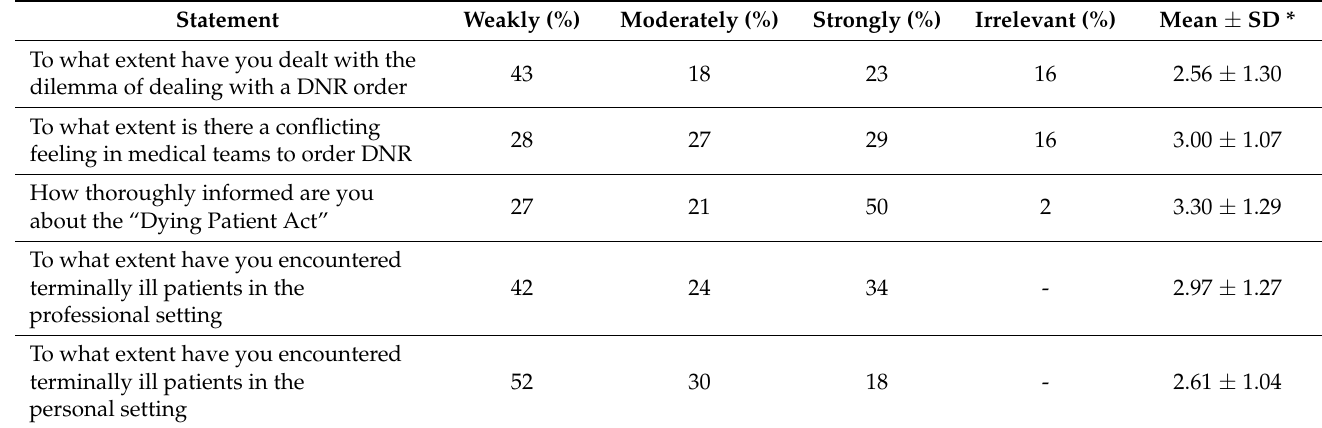
Table 3. Distribution of Responses about DNR procedure, Familiarity with the “Dying Patient Act” and Previous Encounters with Terminally Ill Patients ( n = 135).